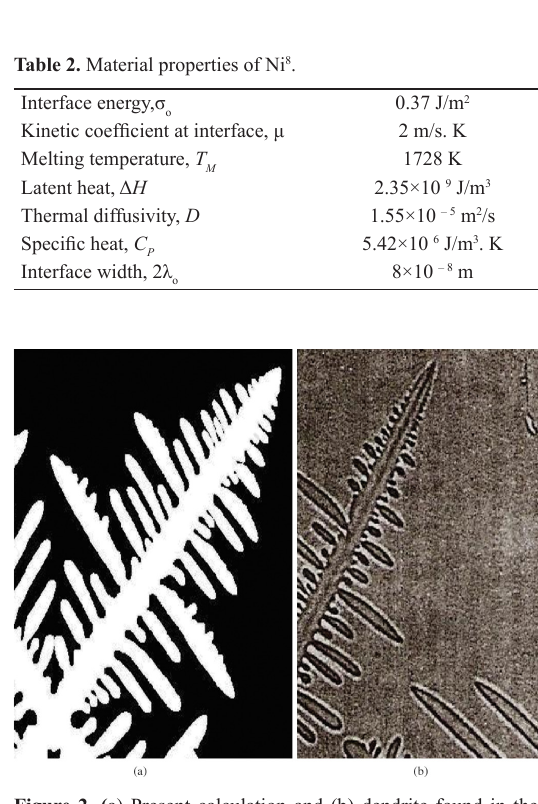
Figure 2. ( a) Present calculation and (b) dendrite found in the literature, Prates 11 .